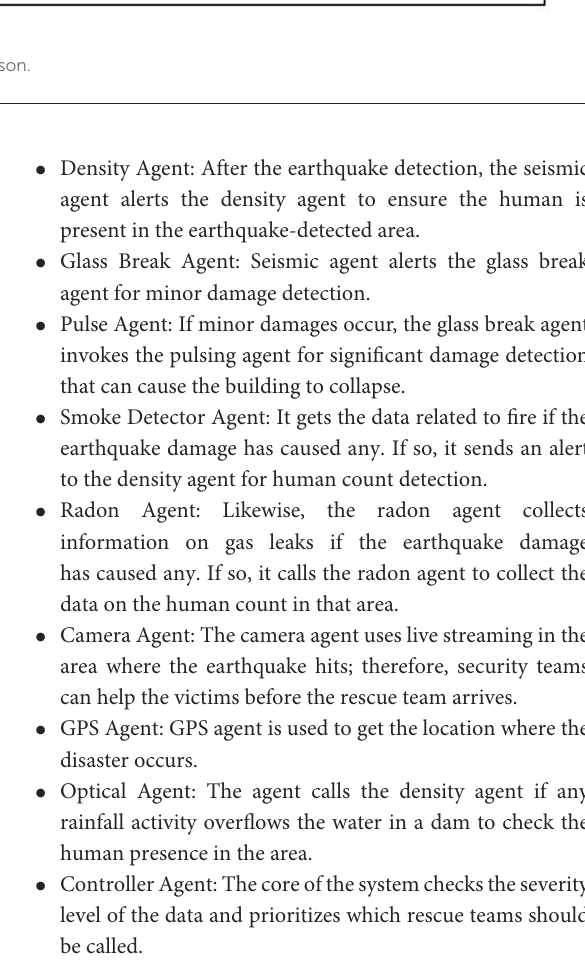
FIGURE9 MATLAB code written for sending an email alert to the corresponding person.